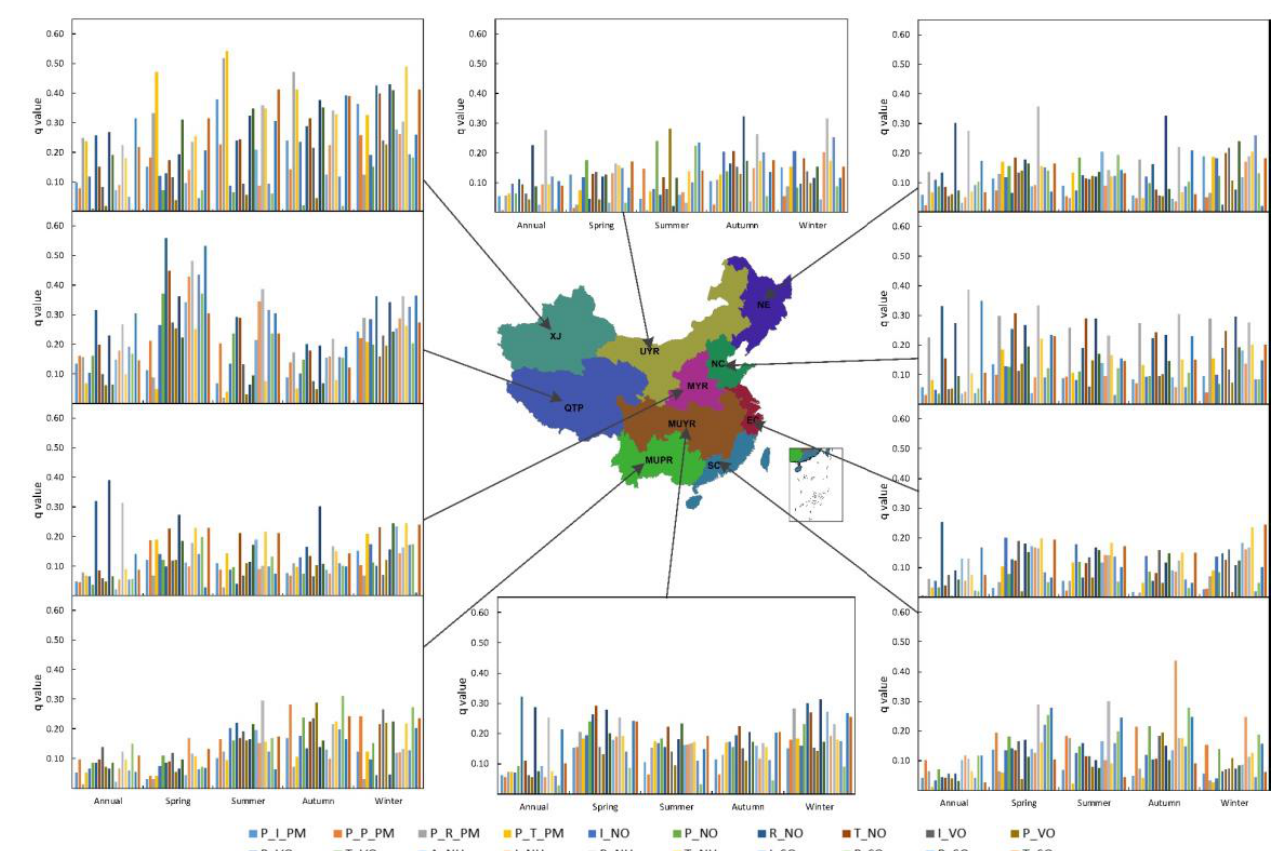
Figure 3. The q value of the driving factor on the regional annual and seasonal scales. (P_I_PM denotes primary industry PM 2.5 ; P_P_PM denotes primary power PM 2.5 ; P_R_PM denotes primary residential PM 2.5 ; P_T_PM denotes primary transportation PM 2.5 ; I_NO denotes industrial NO X ; P_NO denotes power NO X ; R_NO denotes residential NO X ;